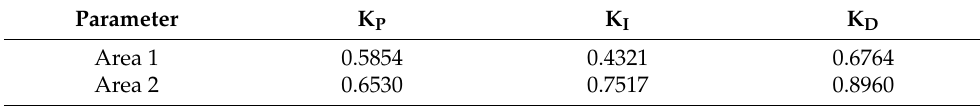
Table 8. PID controller parameters with a 0.2 s delay.